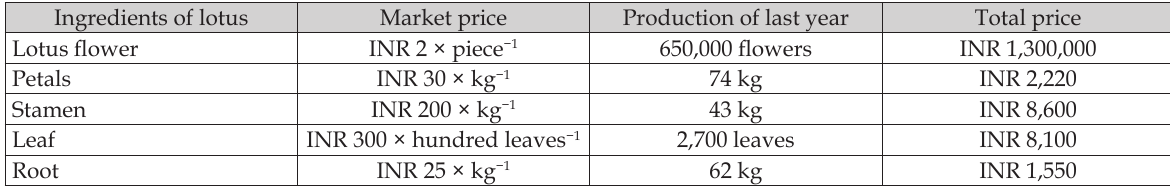
Table 8. Total value of lotus and associated parts in Suraha Tal Wetland in 2015.